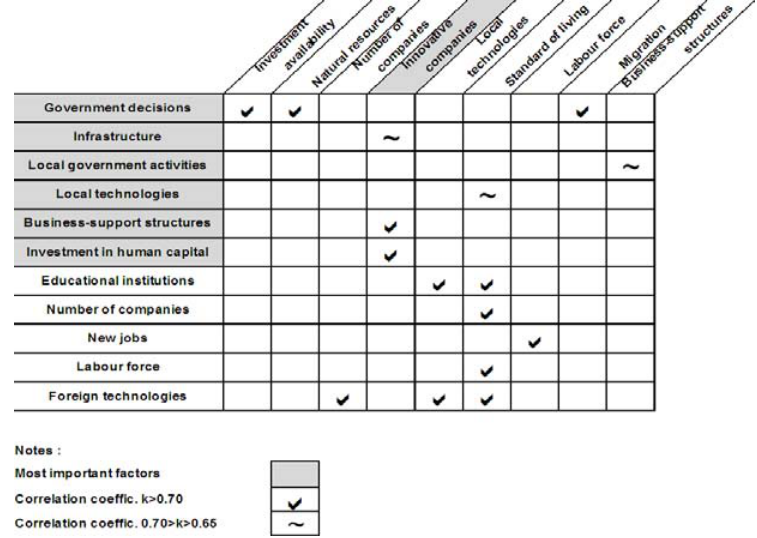
Fig. 6. Correlations between the main factors influencing Latvian regional